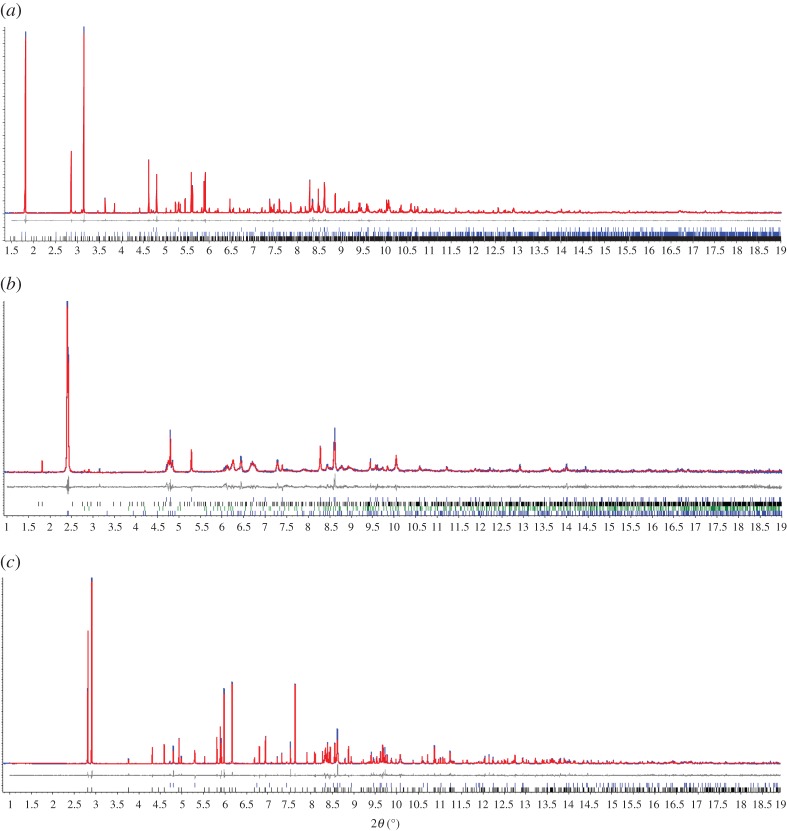
Observed (blue) and calculated (red) profiles and difference plot [(Iobs − Icalcd)] (grey) at 298 K (1.0 ≤ 2θ ≤ 19.0°, dmin = 1.22 Å) of (a) the joint Pawley refinement for 1-MeOH and 1 and Rietveld refinement [37] for Ag2CO3 (Rwp = 0.081; Rwp′ = 0.125); (b) the Pawley refinement of the intermediate phase (see below) and Rietveld refinement for 1, 2 and Ag2CO3 (Rwp = 0.181; Rwp′ = 0.308); (c) Rietveld refinement of 2 and Ag2CO3 (Rwp = 0.194; Rwp′ = 0.270).